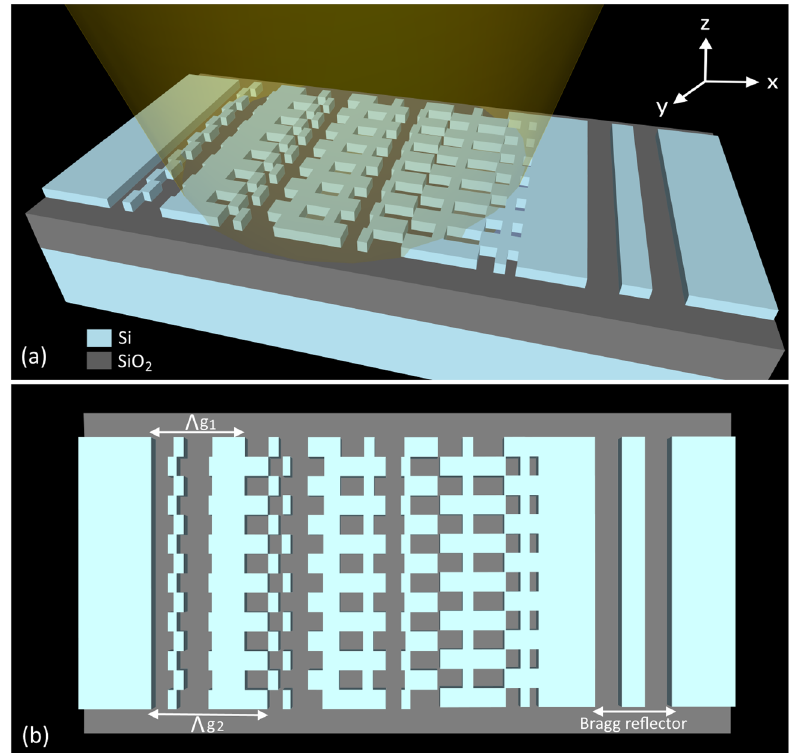
Figure 3. ( a ) Transversally interleaved antenna schematics. The incident light propagates along the x direction, being diffracted of-chip by the antenna nanostructure. The residual power propagating in the waveguide plane is re-injected to the antenna by a terminal Bragg reflector. ( b ) The antenna top view (x–y